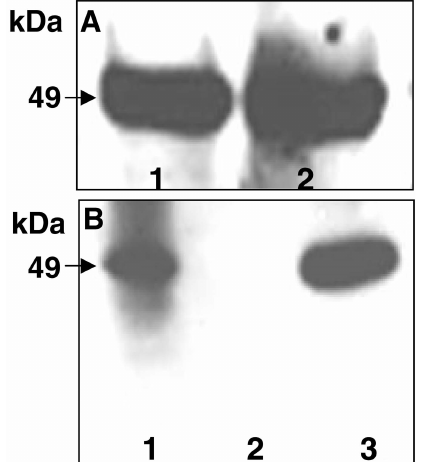
Figure 1. D -Lactate dehydrogenase is expressed constitutively. Lac- tate- (A) and pyruvate-grown (B) cell samples were separated on SDS-PAGE gels and probed with anti-Dld antibody. (A) Lane 1: A. fulgidus soluble fraction; Lane 2: A. fulgidus membrane fraction. (B) Lane 1: A. fulgidus soluble fraction;Lane 2: empty;Lane 3: A. ful- gidus membrane fraction. (Prestained protein standards (Gibco) are not